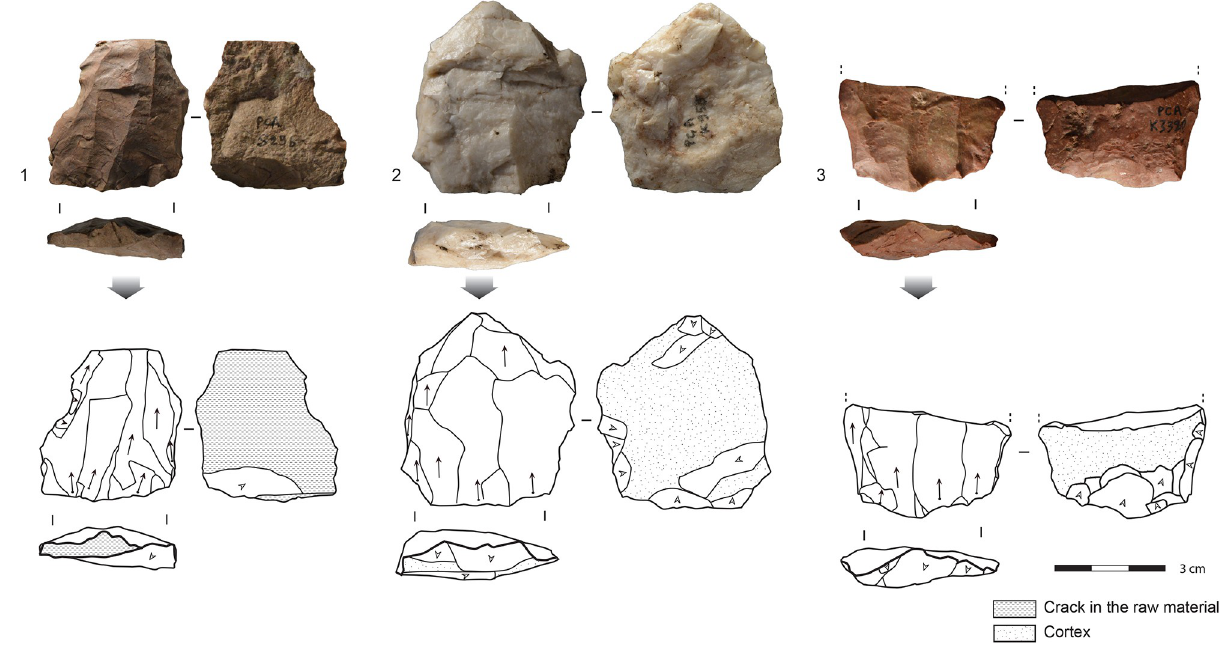
Fig 4. Examples of typical HP cores from layer PCA. 1,3: Silcrete. 2: Quartz.